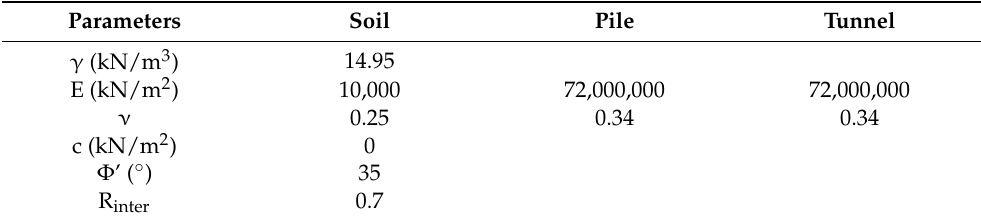
Table 5. Material properties for numerical analysis.